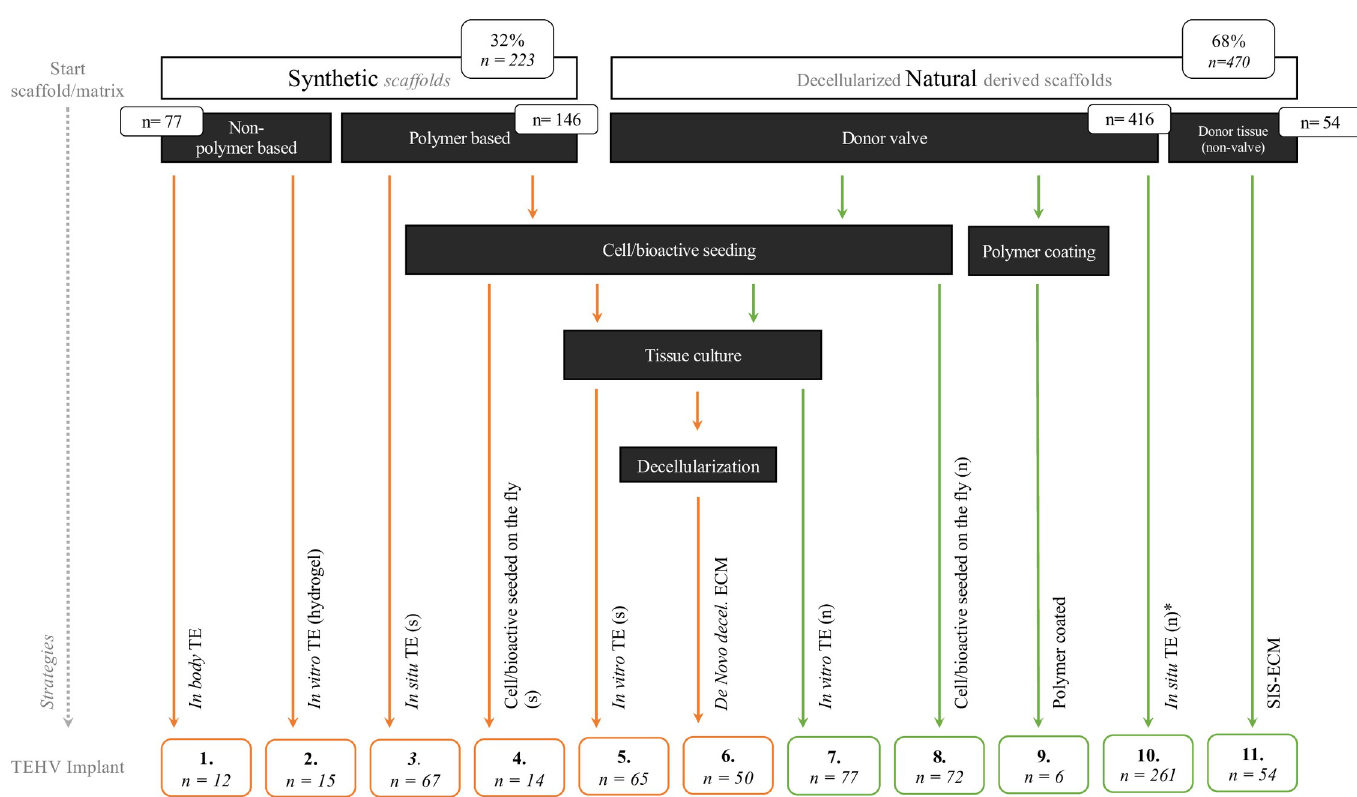
Fig 4. Overview of strategies in tissue engineering of heart valves. Start with the scaffold materials (synthetic or natural), subsequent the pathways of preparation techniques prior to implantation. Finally, 11 strategies were identified. n = numbers of valves represented in each group . TE; Tissue engineering . SIS-ECM; Small intestinal submucosa extra cellular matrix . � Decellularized . Xeno-/autografts